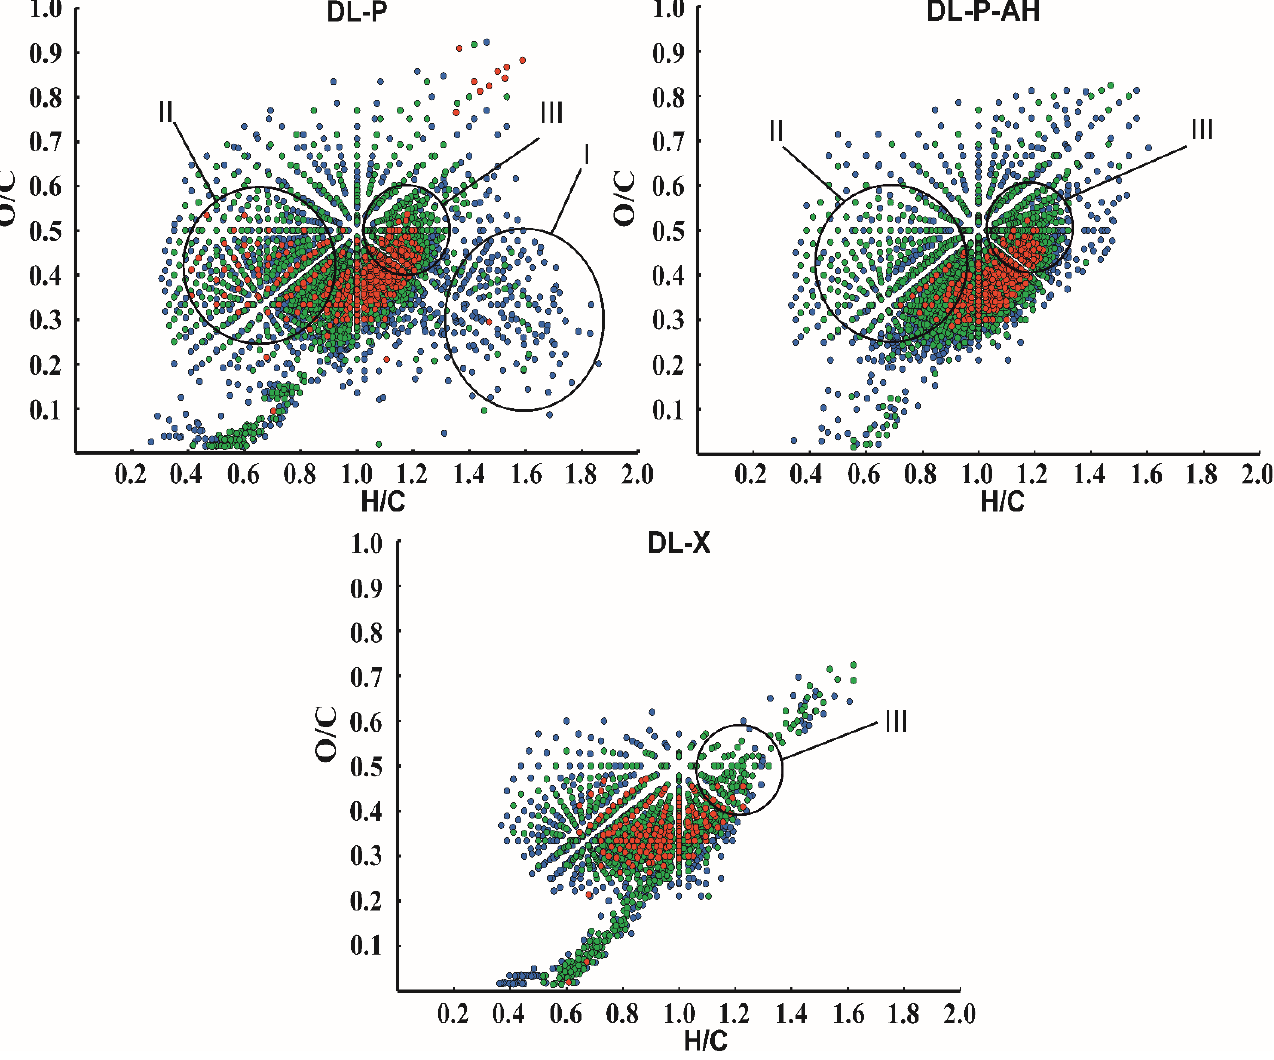
Figure 5. Van Krevelen plots for DL-P, DL-P-AH and DL-X lignin preparations obtained from negative ion mode APPI-Orbitrap mass spectra. The color coding indicates the relative intensity of the signals in the mass spectrum: red, 100–10%; green, 10–1%; and blue, 1–0.1%.